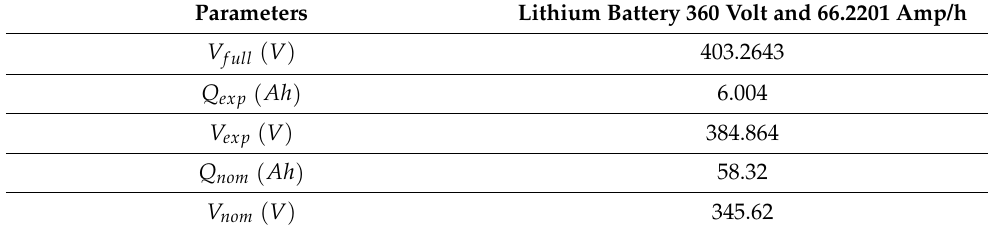
Table 2. Extracted values of the discharge curve.